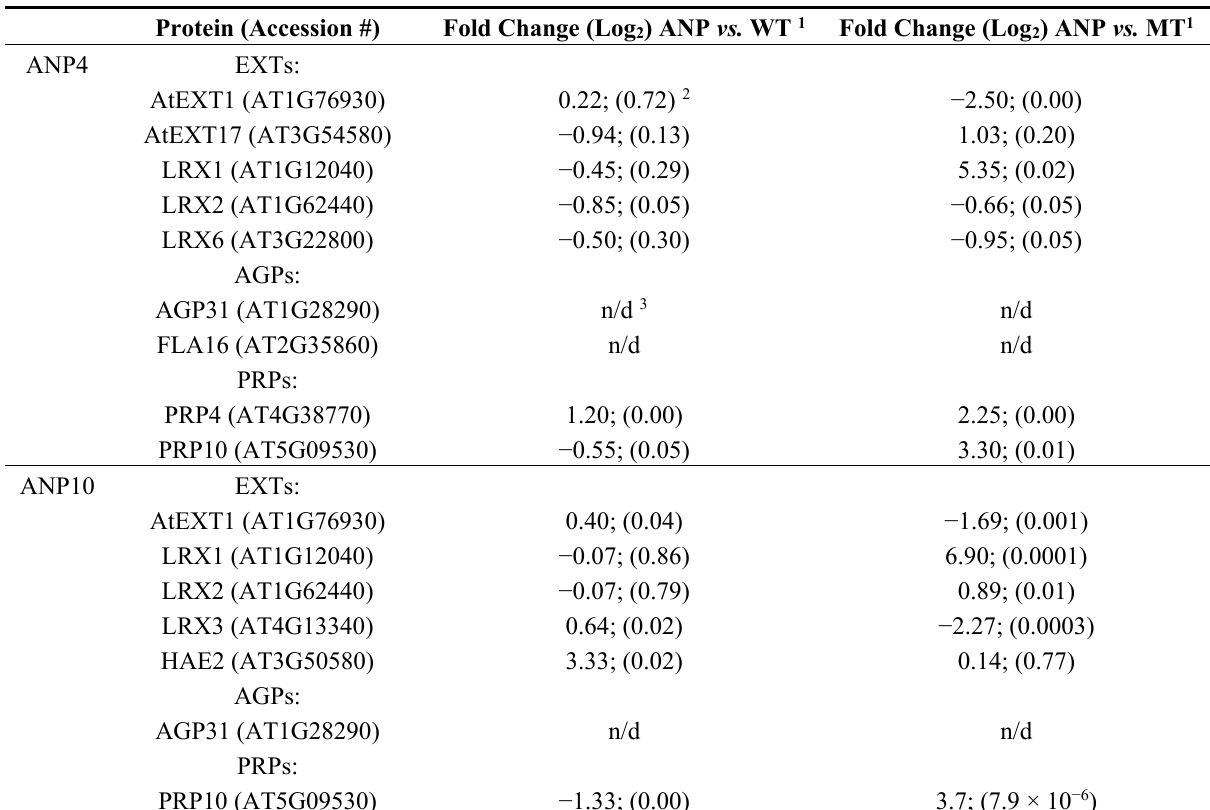
Table 4. Gene Expression Patterns of Proteomics Identified ANP HRGPs using qRT-PCR: A Comparing of WT and rsh Mutant and ANP